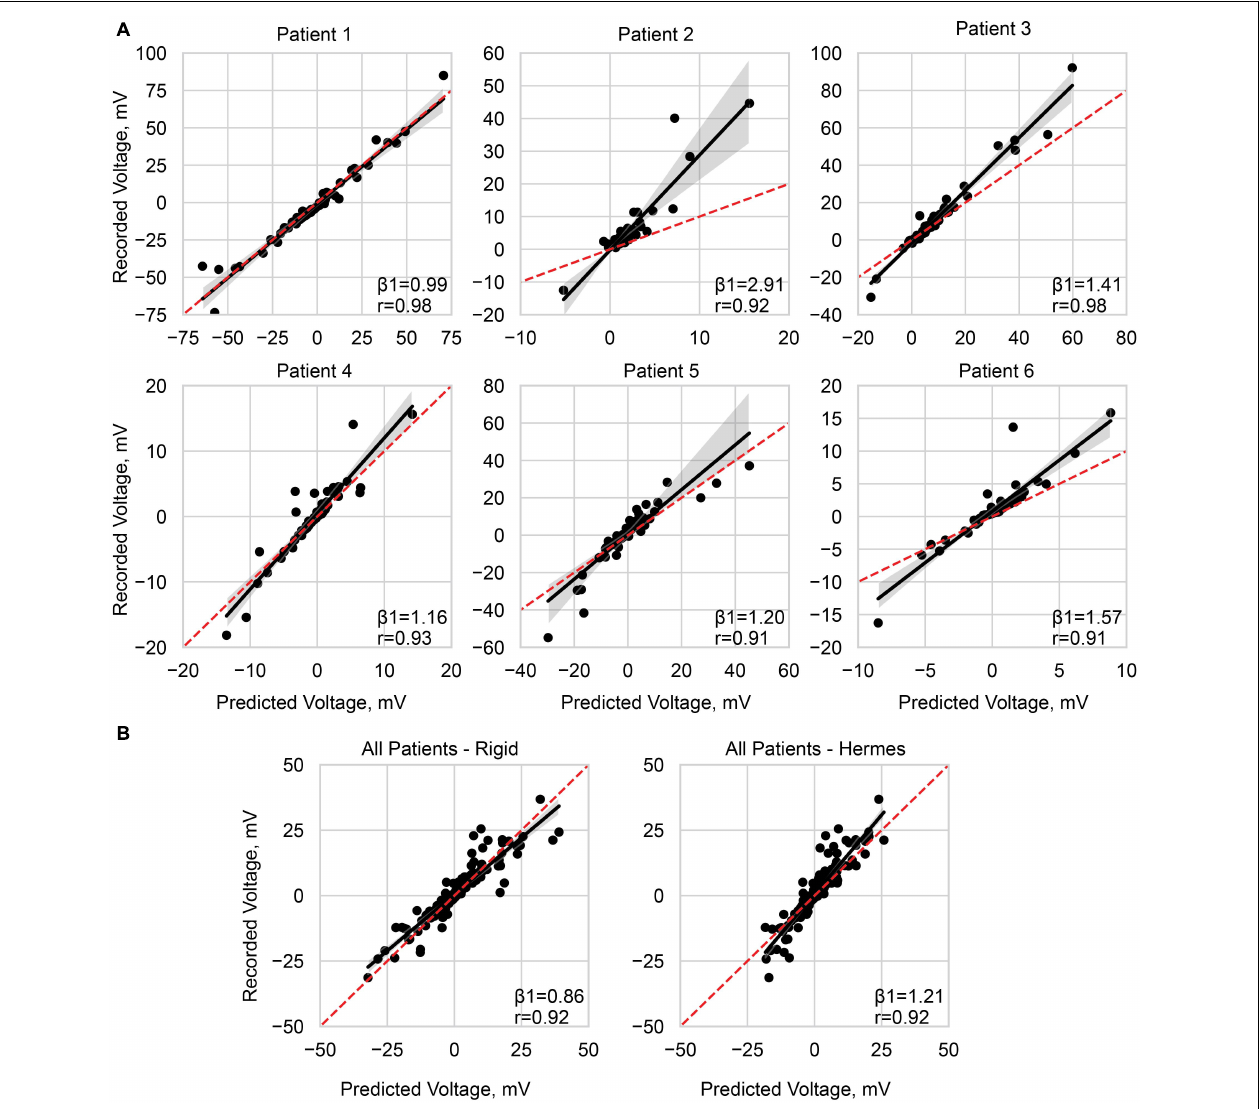
FIGURE 7 | Predicting the recorded voltage. (A) Linear regression of the predicted voltage using the Hermes projection method and the clinically recorded voltages for each patient. (B) Linear regression across all patients, with a normalized stimulation amplitude of 1 mA, for the rigid method and Hermes method. Each data point represents a single electrode on the ECoG grid. The red dashed line is unity, and the shaded gray region is the 95% confidence interval. Slope ( β 1) and Pearson correlation coefficient ( r ) are shown on each plot, and additional statistics are available in Table 3